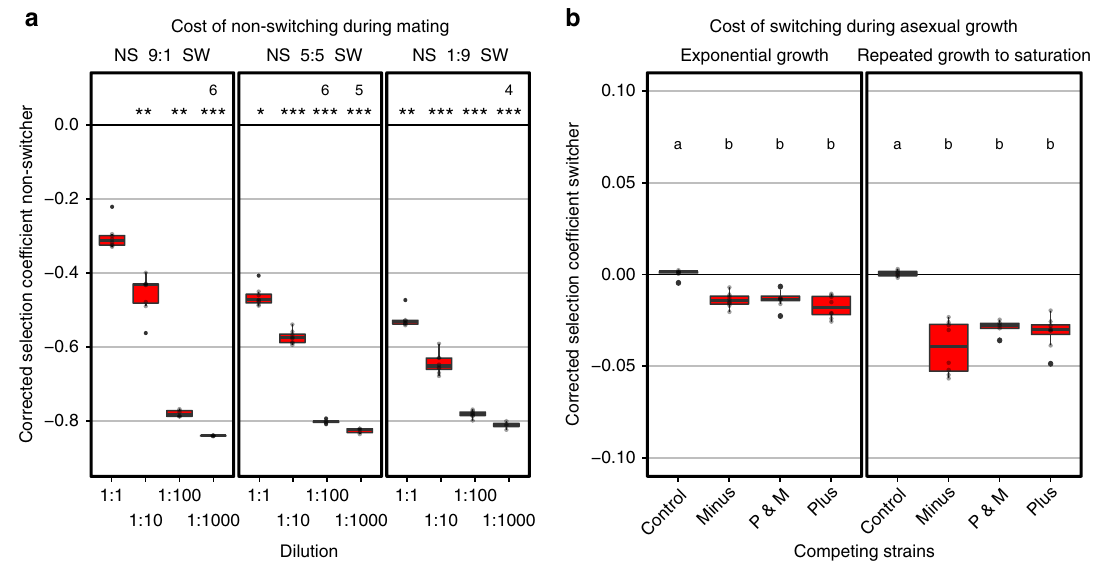
Fig. 3 Fitness bene fi ts and costs of mating-type switching (MTS) during sexual and asexual reproduction. a Selection coef fi cients for non-switchers (NS), relative to switchers (SW), after one round of sexual reproduction under four different densities in a structured environment (8.0 × 10 5 cells mm − 2 in highest density) on inverted y -axis to indicate reduction in fi tness. Non-switchers decrease in fi tness at low densities and the bene fi t of switching is the highest when switchers are at high frequency in the population, regardless of density. The boxplots are based on eight biological replicates (open circles; exceptions are indicated by number above box; see Methods). All strains competing are isogenic, except for mCherry marker and switching locus. Asterisks indicates signi fi cant deviation from the control (Dunn ’ s Kruskal-Wallis multiple comparison, * p < 0.05, ** p < 0.01, *** p < 0.001). b Per generation selection coef fi cient for unlabelled switcher, relative to mCherry labelled non-switchers of M, P or a mixture of equal numbers of P and M, under asexual growth after 5 days of exponential growth (~45 generations; left panel) or after fi ve transfers of growth to saturation (~33 generations; right panel). Control is the competition between the wild-type strain h 90 (EBC5) and itself but mCherry labelled (EBC47). Each boxplot consists of eight technical replicates (grey dots). Letters within each panel indicate signi fi cantly different groups based on Dunn ’ s Kruskal – Wallis multiple comparison ( p < 0.05). Note inverted